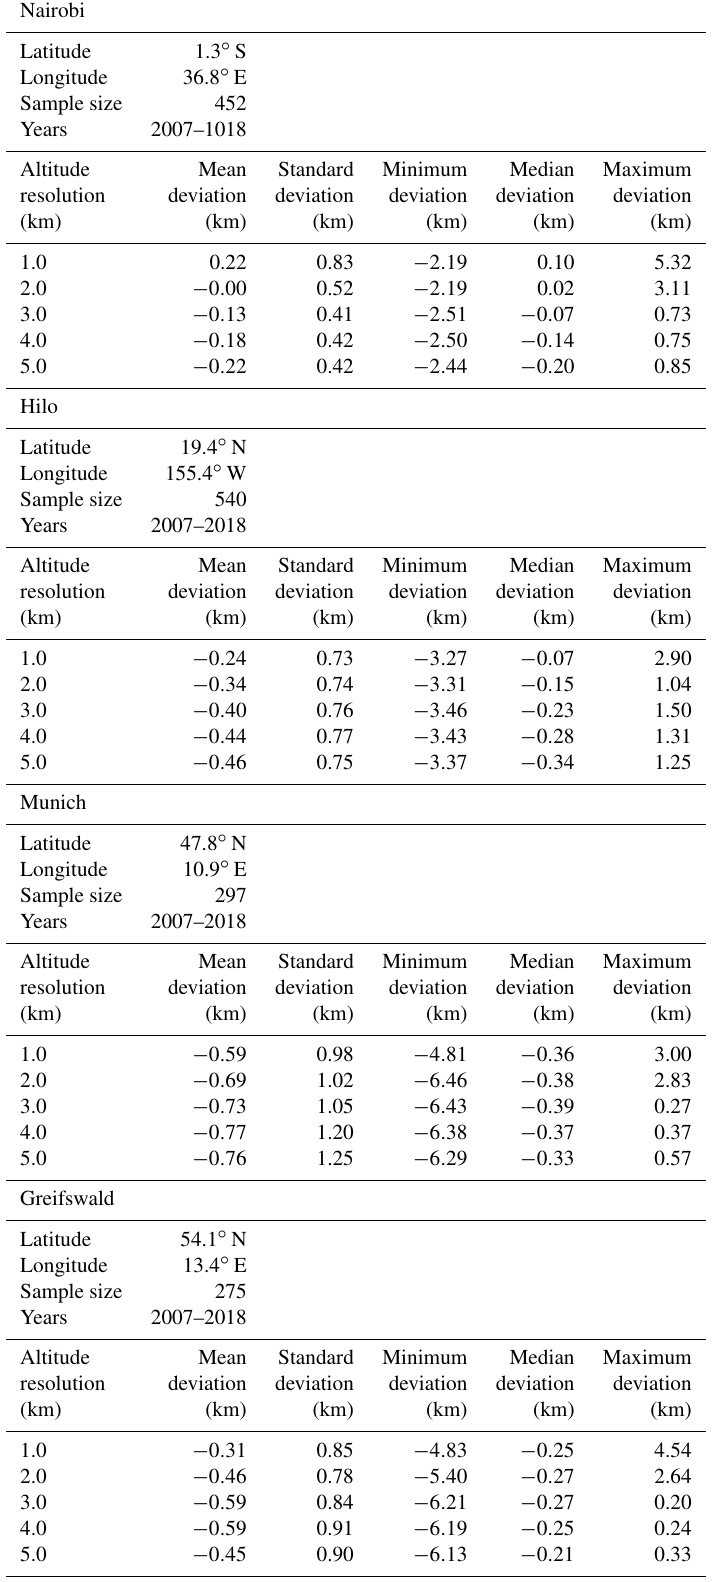
Table 1. Statistics for lapse rate tropopause